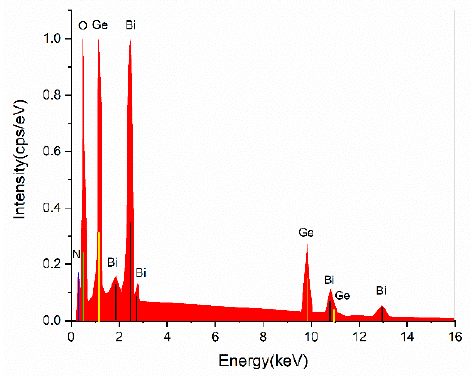
Figure 3. Elemental analysis of the sample prepared by the bismuth nitrate precursor. Table 1. Atomic concentrations of the main elements in the sample prepared by the bismuth nitrate precursor.